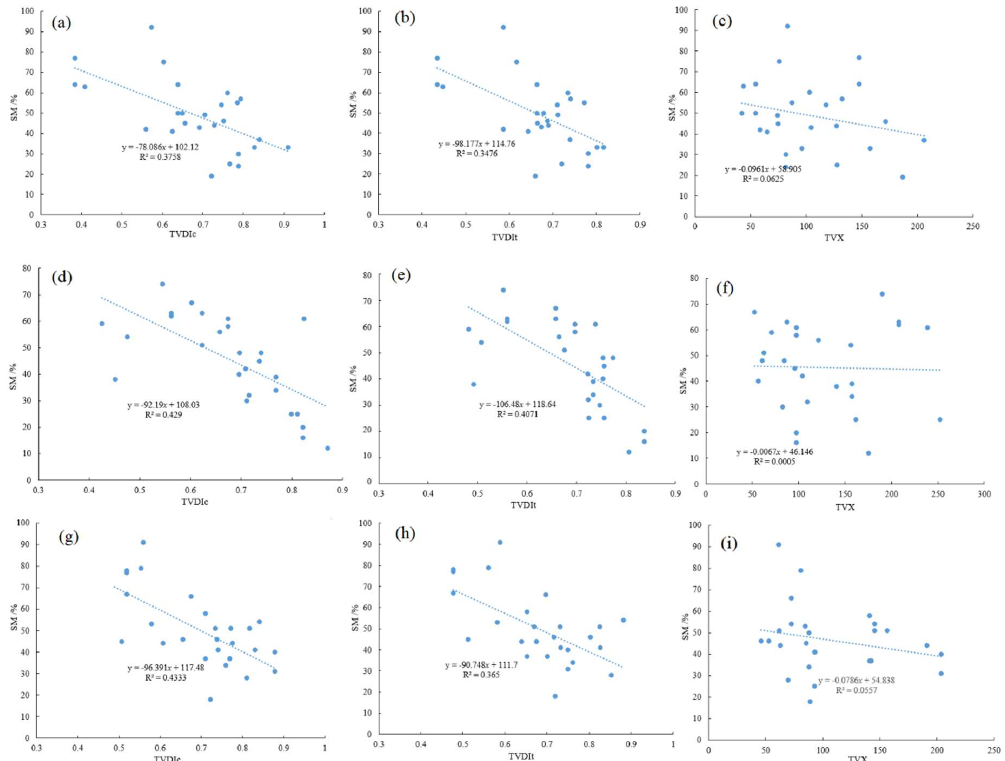
Figure 9. Comparison of TVDI c , TVDI t , and TVX with 10 cm soil moisture. ( a ) TVDI c against 10 cm soil moisture during 7 April 2013–14 April 2013, ( b ) TVDI t against 10 cm soil moisture during 7 April